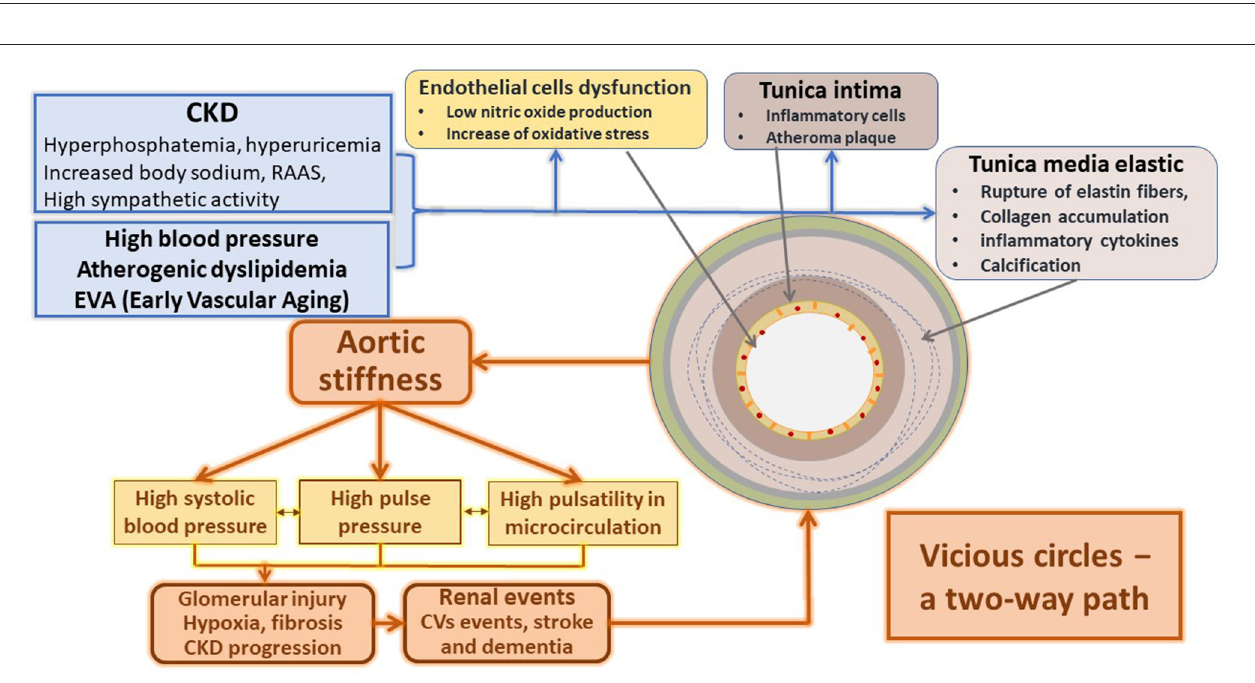
FIGURE 2 | Main mechanisms responsible for the structural and functional changes of the arteries in CKD.